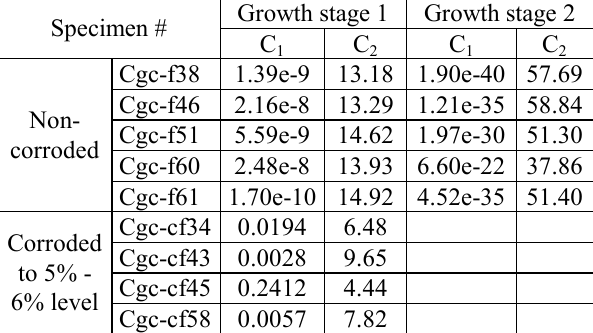
Table 2. Constants in fitted growth curves